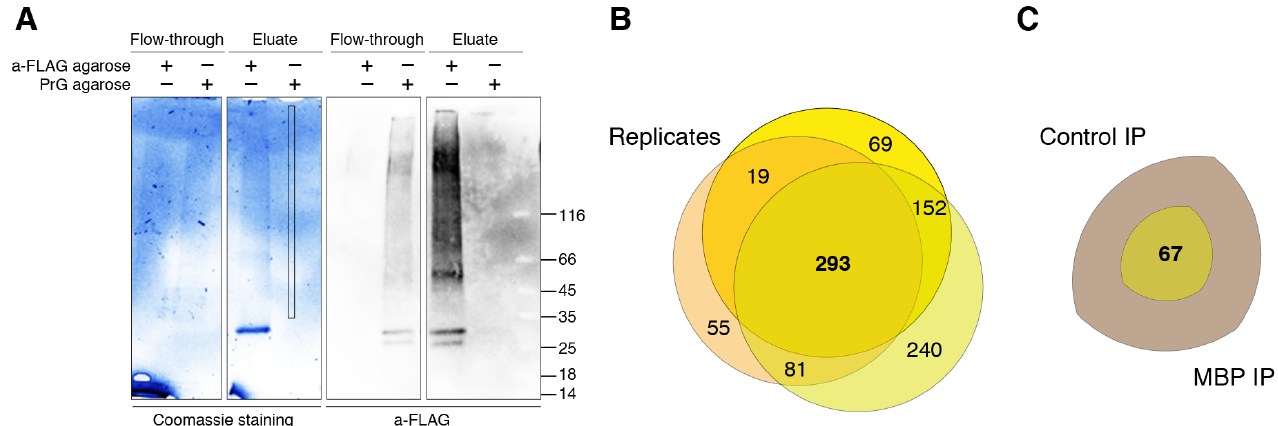
Figure 2 . MBP immunoprecipitation and LS-MS/MS data. ( A ) Crosslinked MBP immunocomplexes resolved in gradient TGX Stain-Free Precast Gel (left) and immunostained with anti-Flag Ab (right). Analyzed zone is marked. ( B ) Venn diagram representing proteins identified in three experiments (with triplicate repeats in each) of immunoprecipitation against Flag-tagged human MBP. ( C ) Venn diagram representing unique and reproducible proteins identified in immunoprecipitation against Flag-tagged human MBP compared to negative control.